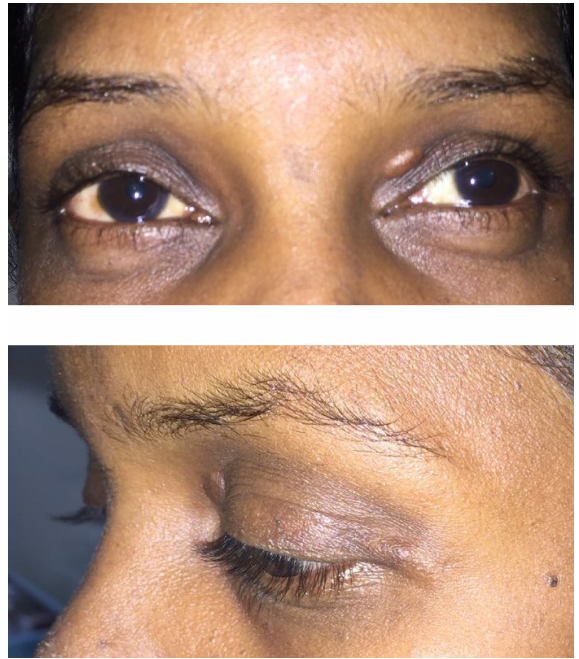
Figure 5: External photographs of the solitary lesion in the left